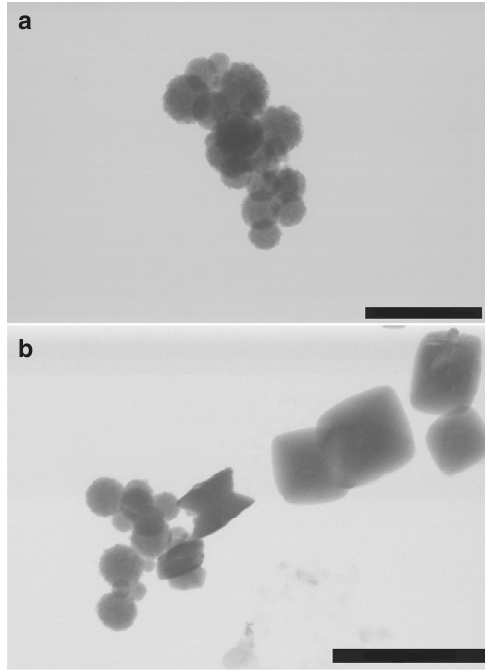
Fig. 2 Scanning transmission electron microscopy images of precipitates formed in rapid mixing experiments (control runs). Coexistence of a rounded nanoparticles (possibly amorphous) and b crystalline calcium oxalate is observed. Scale bars : 500 nm